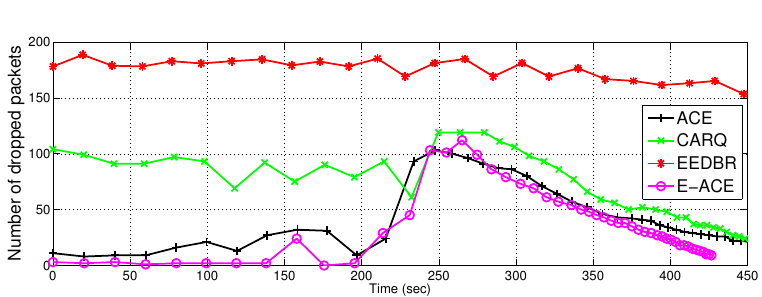
Figure 11. Packets